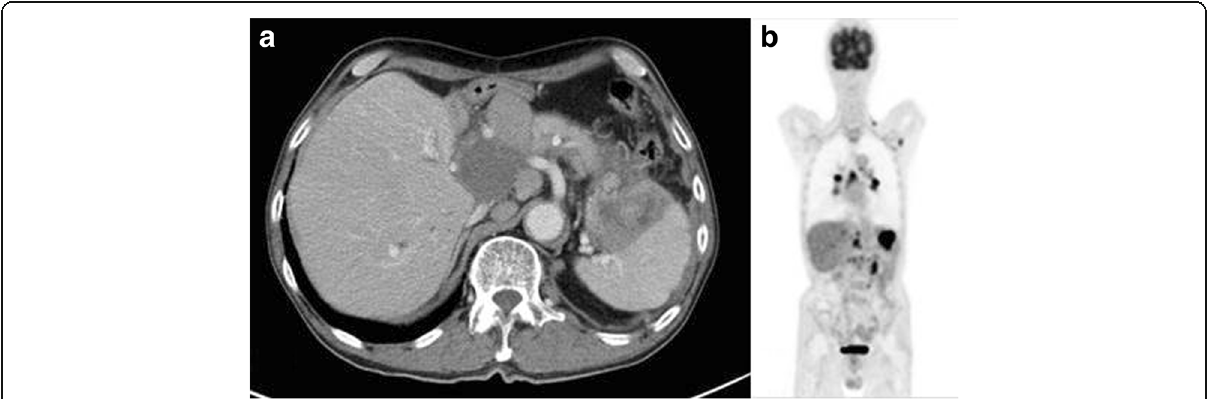
Fig. 1 Imaging findings at the time of admission. a The first computed tomography (CT) demonstrated systemic lymphadenopathy, mainly in the abdomen. The large lymphadenopathy in the splenic hilum seemed to be a gastric submucosal tumor. b Fluorodeoxyglucose positron emission tomography showed systemic uptake, mainly in the intraabdominal lymph nodes. The largest uptake corresponded to the lymphadenopathy in the splenic hilum, as observed on